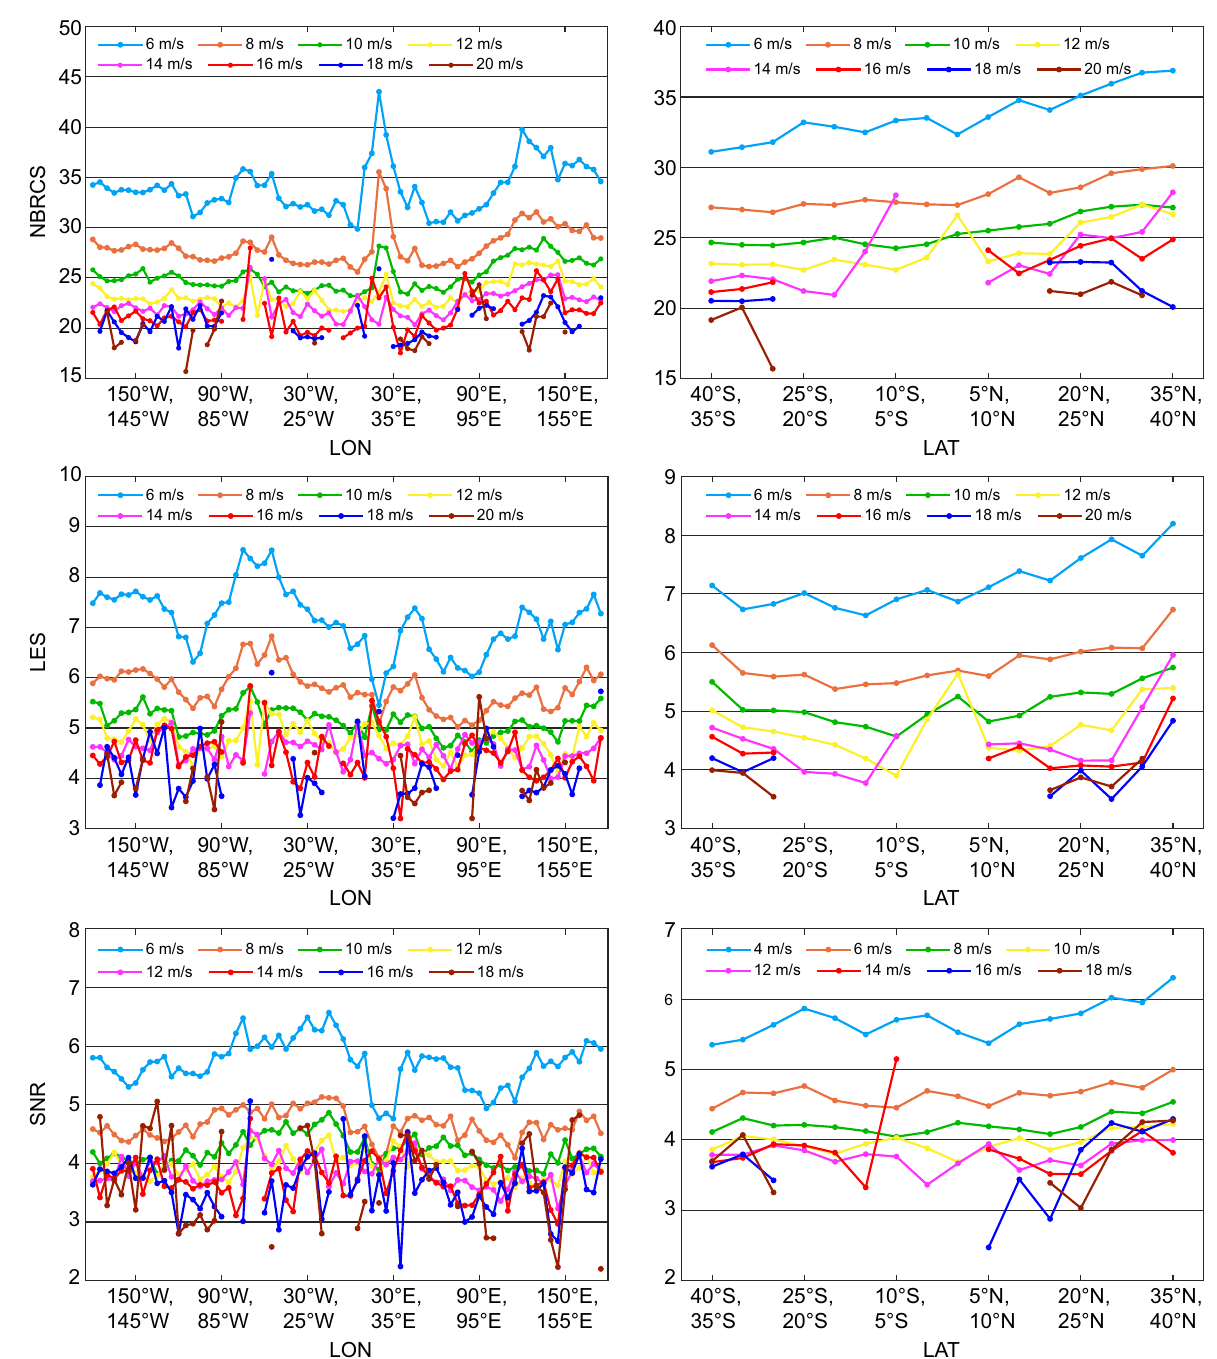
Fig. 2 The variations of observables along longitude and